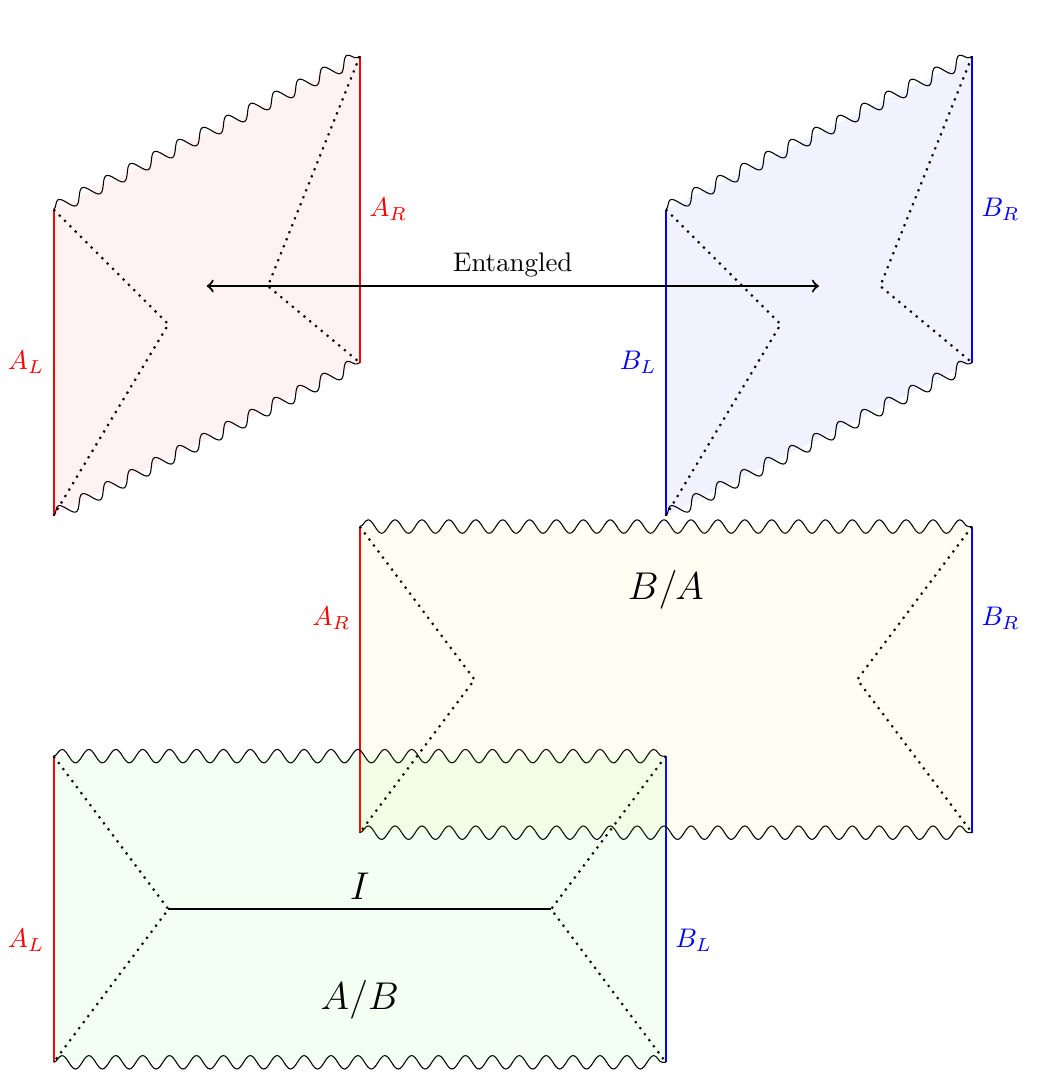
Figure 2 . Schematic picture of two phases of entangled two universes (AdS) A, B . (Top) The two universes are disjoint and just entangled with each other. In this case, the entanglement entropy of the state (1.2) on the universe A is the Hawking-like thermal entropy S th ( β ) . (Bottom) A sufficiently large entanglement between the two universes induces the geometric connection of the two spacetimes, resulting in two glued spacetimes A/B and B/A . Unlike the above disjoint universes, since there is an island in the glued spacetime A/B , the entanglement entropy of the universe A is given by the black hole entropy of the glued spacetime A/B